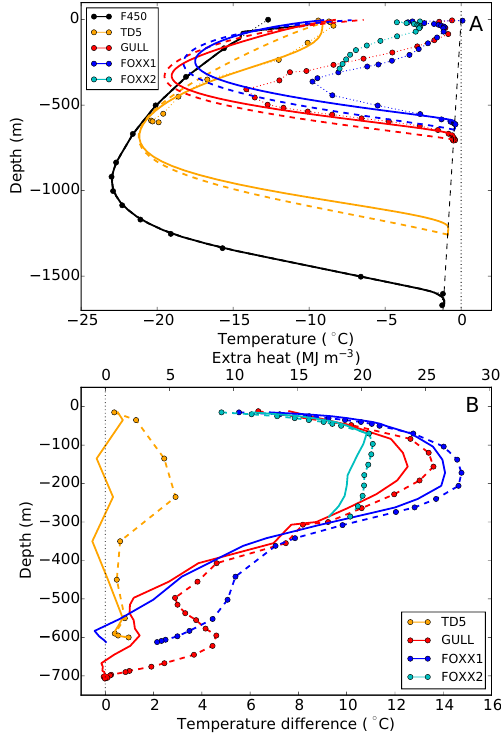
Figure 5. Measured and modeled temperatures at the three sites Swiss Camp (TD5), GULL and FOXX. Symbols connected by dot- ted lines indicate measurements. Dashed lines refer to the reference model run mD (dissipation only). Solid lines refer to run mE (ad- ditional heat sources from enhanced shear straining in ice-age ice). The scale on top of the lower panel shows the extra heat per volume with respect to model run mD (dissipation only).